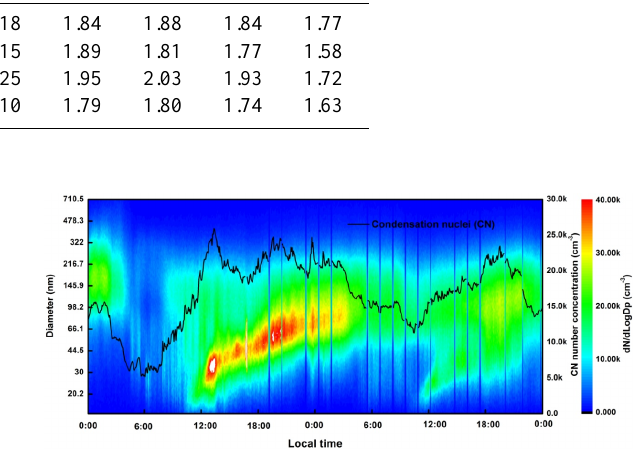
Figure 4. Temporal evolution of 4min mean aerosol size spectra, showing new particle formation and subsequent growth on 3 and 4 April